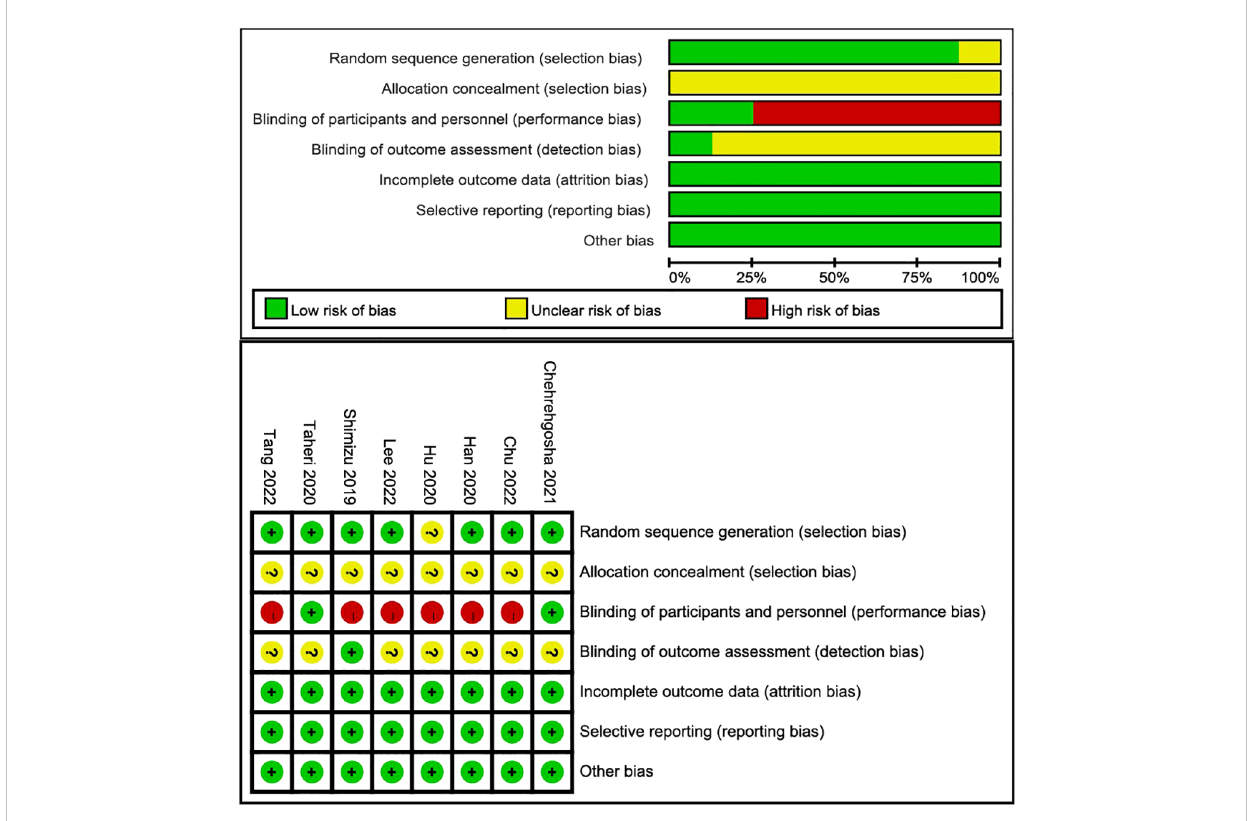
FIGURE 2 Risk-of-bias graph and risk-of-bias summary.